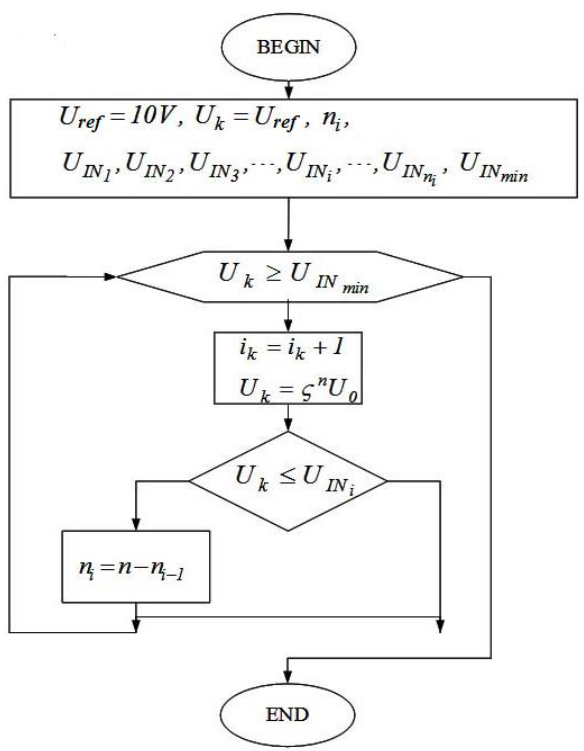
Figure 2. Generalised block diagram of the algorithm of operation of a multi-input multifunctional ADCF. Figure 2 includes: U k —compensation voltage, U IN min —the smallest of the input voltages, U ref —reference voltage, i k —number of dosing—processing steps, n i —number of logarithmising circuit capacitor cells in which processing takes